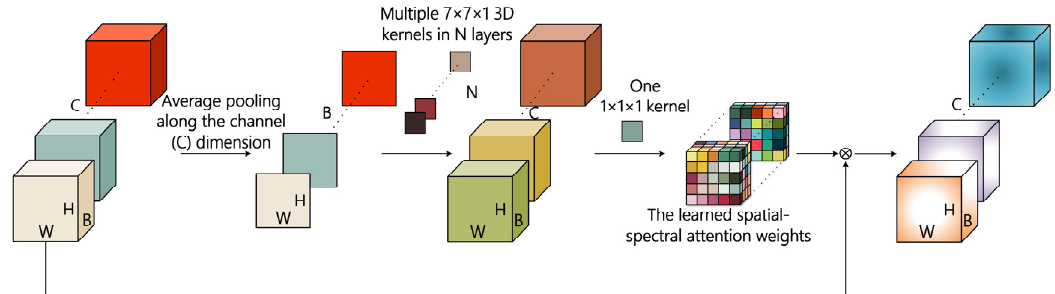
Figure 2. Schematic diagram of LA-3D-Conv structure.